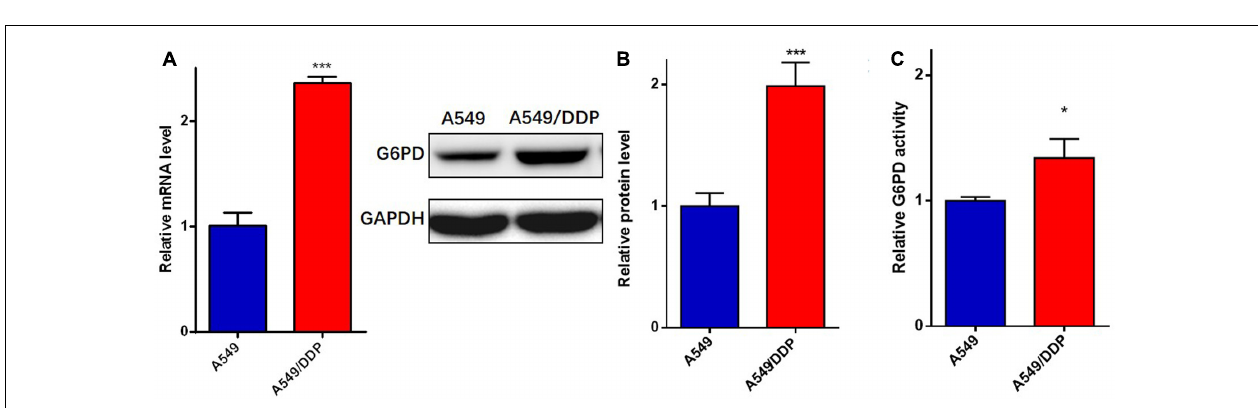
FIGURE 3 | A549/DDP cells displayed higher expression and enzymatic activity of G6PD. The (A) mRNA, (B) total protein, and (C) enzymatic activity of G6PD were assessed in A549 and A549/DDP cells. Data are represented as the means ± SD ( n = 3), and significant differences are indicated as ∗ P < 0.05, ∗∗ P < 0.01, and ∗∗∗ P <